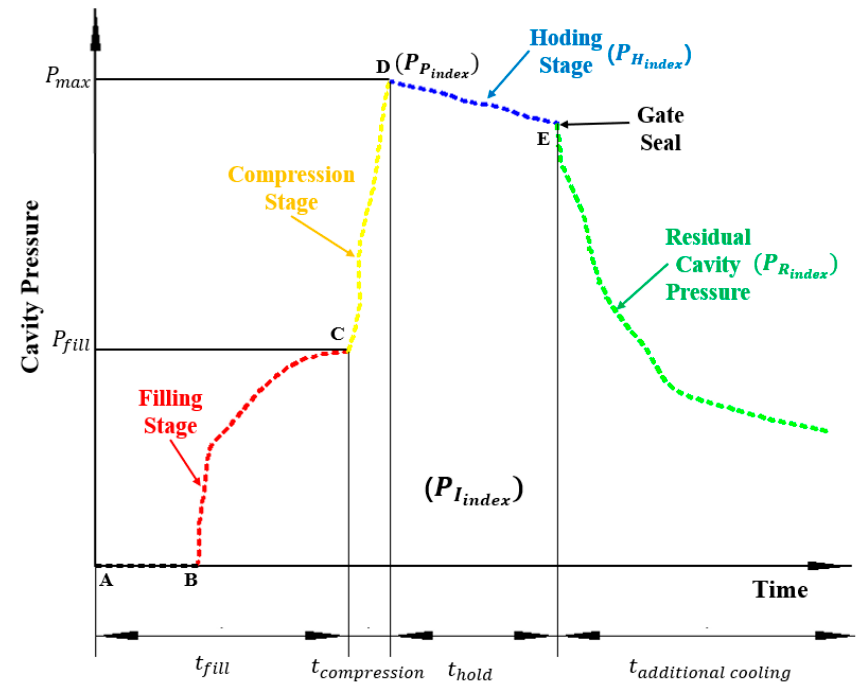
Figure 1. Typical cavity pressure profile.